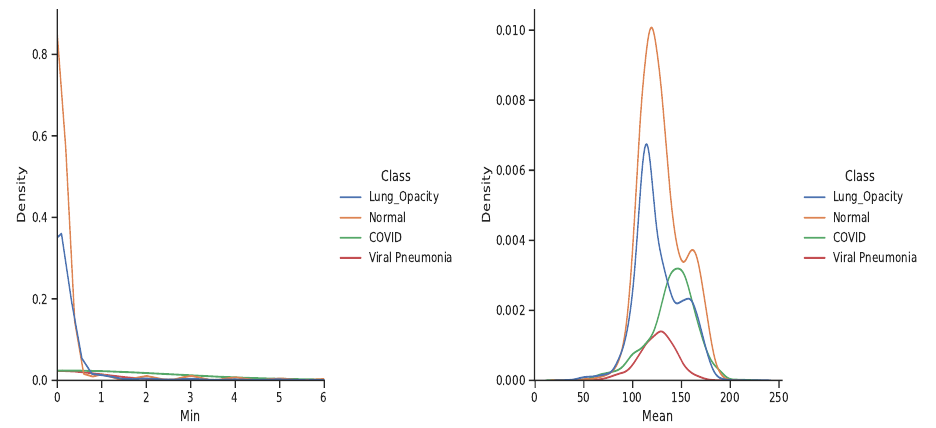
Figure 4. The minimum and mean RGB color intensity distributions for the four X-ray image classes.